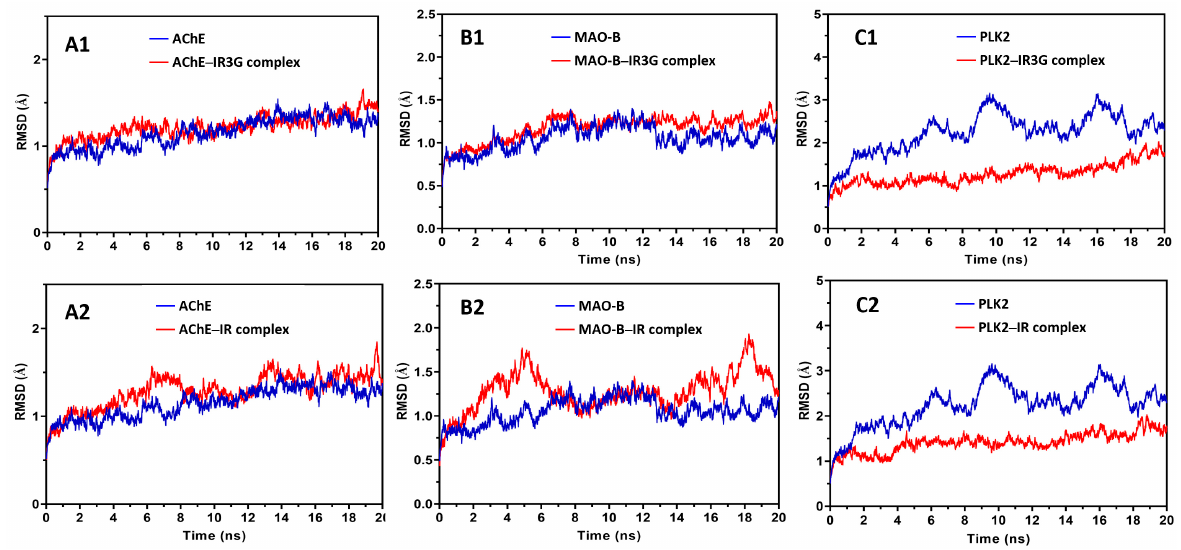
Figure 8. Online color molecular dynamic (MD) simulation analysis of isorhamnetin ‐ 3 ‐ O ‐β‐ D ‐ glucoside (IR3G) with AChE ( A1 ), MAO ‐ B ( B1 ), and PLK2 ( C1 ) complexes and MD simulation analysis of isorhamnetin (IR) with AChE ( A2 ), MAO ‐ B ( B2 ), and PLK2 ( C2 ) complexes. The RMSD values of the protein backbone (blue) and protein–ligand complex (red) from their initial docking coordinates are presented.